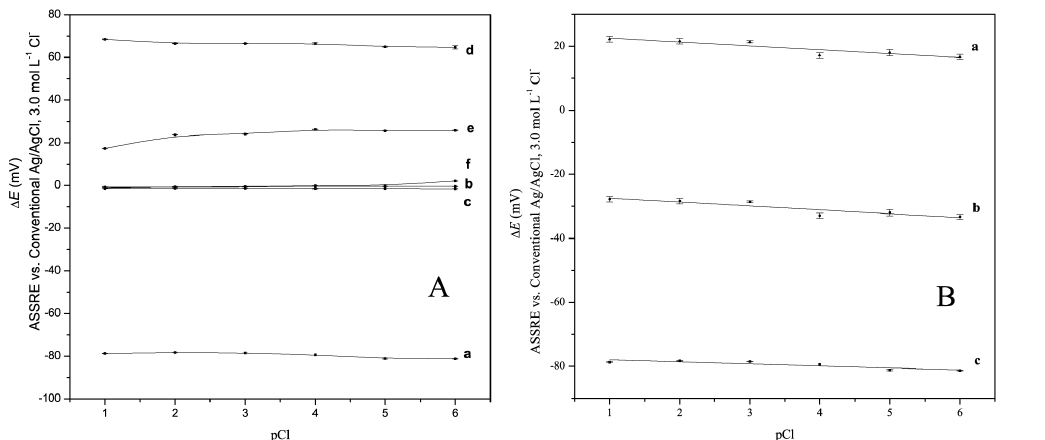
Figure 4. Behaviour of all-solid-state reference electrodes after the sterilization and diffusion process in deionized water during 20 days. Curves obtained in the conditions (A) after sterilization in autoclave with ASSREs containing the salts (a) KCl, (b) KCl : SiO 2 , (c) BaCl 2 , (d) NaF, (e) Na 2 SO 4 , and (f) KI. (B) ASSREs containing KCl at 3.0molkg − 1 (a) after sterilization, (b) after diffusion process, and (c) before everything. Table 3. Results of the determination of potassium ions in real samples using an all-solid-state reference electrode containing 3.0molkg − 1 NaF against ion-selective electrodes for potassium (ISE-K). Samples Nominal Flame photometry Direct potentiometry Relative value (mg) ISE-K vs. C graphite /Ag/AgCl, error 3.0molkg − 1 NaF (mg) (%) #1 18mg/200mL 16 ± 4 a 16 ± 4 b #2 50mg/200mL 43 ± 1